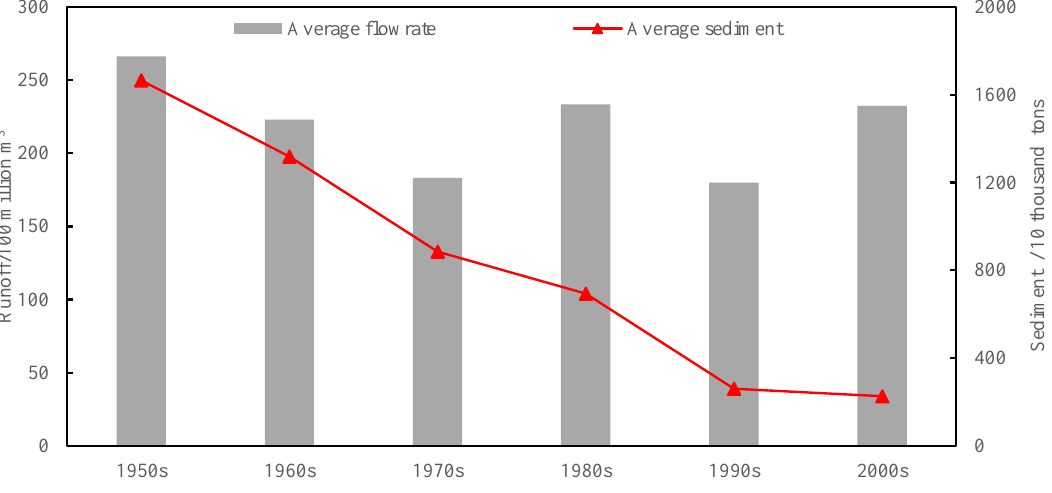
Figure 1. Changes of hydro-sediment in the mainstream of Huai River at Lutaizi station.